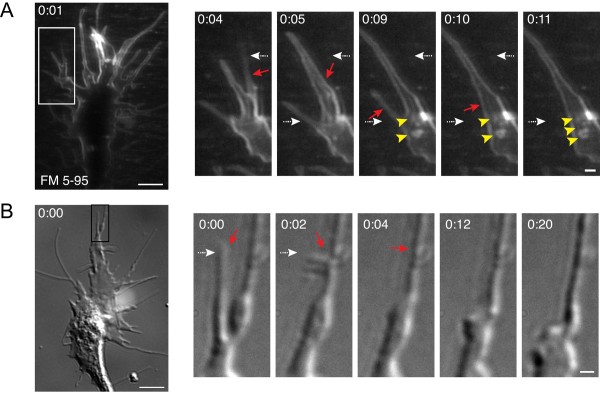
Small vesicle endocytic hot-spots triggered by filopodial contact. (A) Time-lapse confocal images of FM 5-95 internalization show contact and apparent fusion between adjacent filopodia (red arrows). The boxed area is magnified in the panels at the right and the time after the initial membrane labeling (minutes:seconds) is indicated in each frame. The dashed arrows (white) are static and indicate the initial position of filopodia. Filopodial contact and fusion is accompanied by the formation of multiple small endocytic vesicles at the proximal region of the resulting filopodium (yellow arrowheads). See Additional file 6 for the corresponding time-lapse movie. (B) Time-lapse DIC images show similar filopodial-filopodial contacts (red arrows) as in (A). The dashed arrows (white) depict the initial filopodial position. The corresponding time-lapse movie is shown in Additional file 7. Scale bars, 5 μm (left), 1 μm (right).